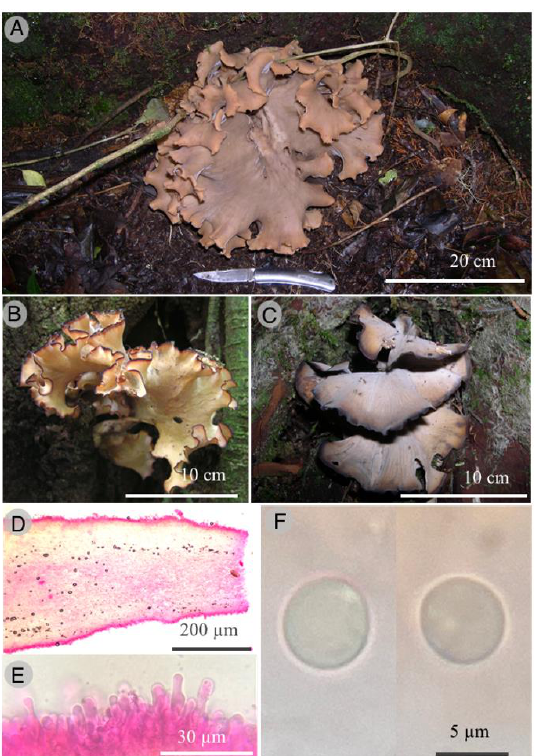
Figure 7. Sparassis isis . ( A – C ): basidiomata; ( D ): optical microscope images of the hymeniiferous trama; ( E ): optical microscope images of hymenium; ( F ): optical microscope images of